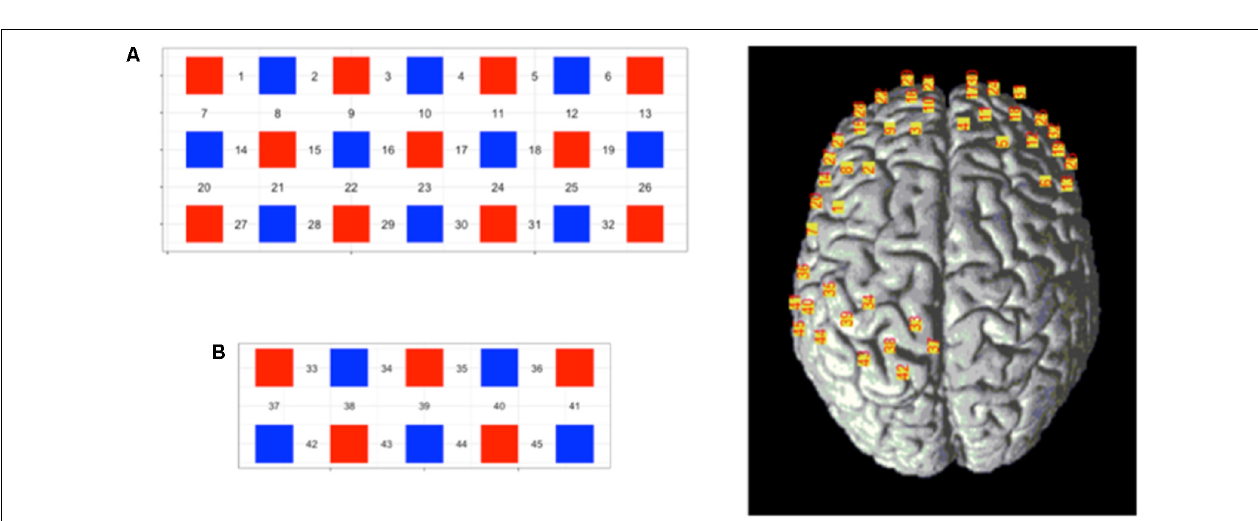
FIGURE 2 | Example of trial events. Each trial displayed the fixation cross (2000 ms) followed by the experimental picture (3000 ms) and the evaluation question, which remained until a response occurred.